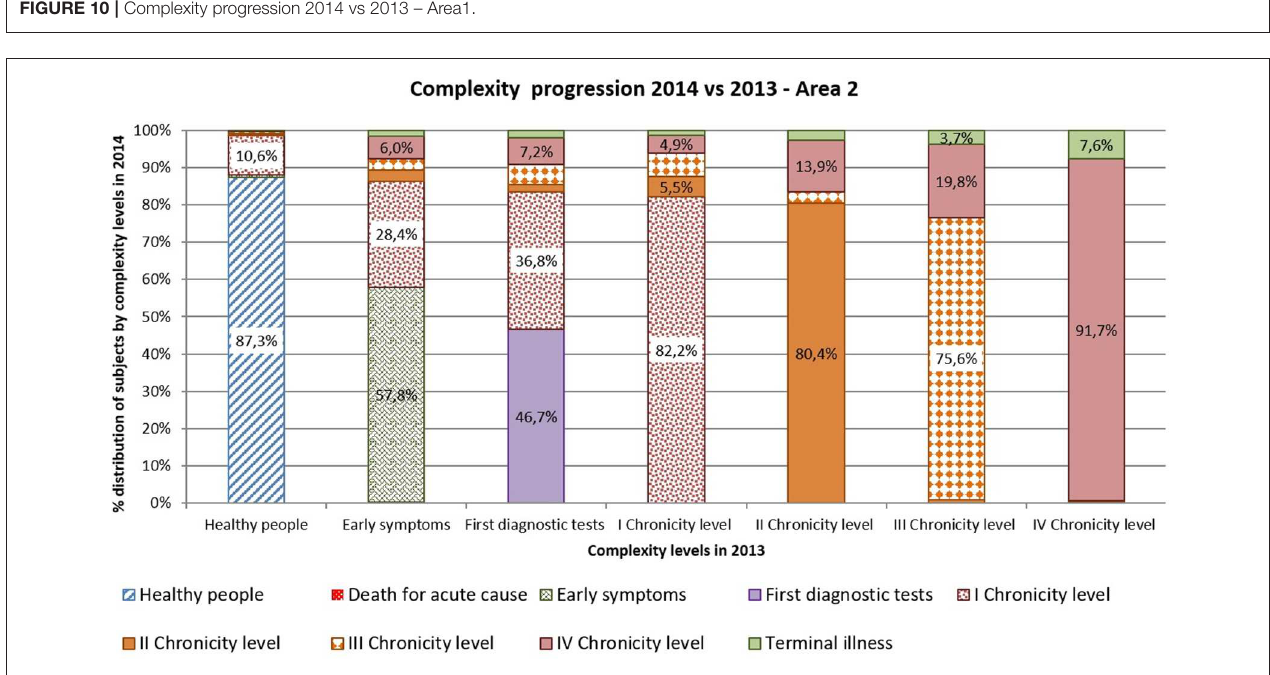
FIGURE 11 | Complexity progression 2014 vs 2013 –